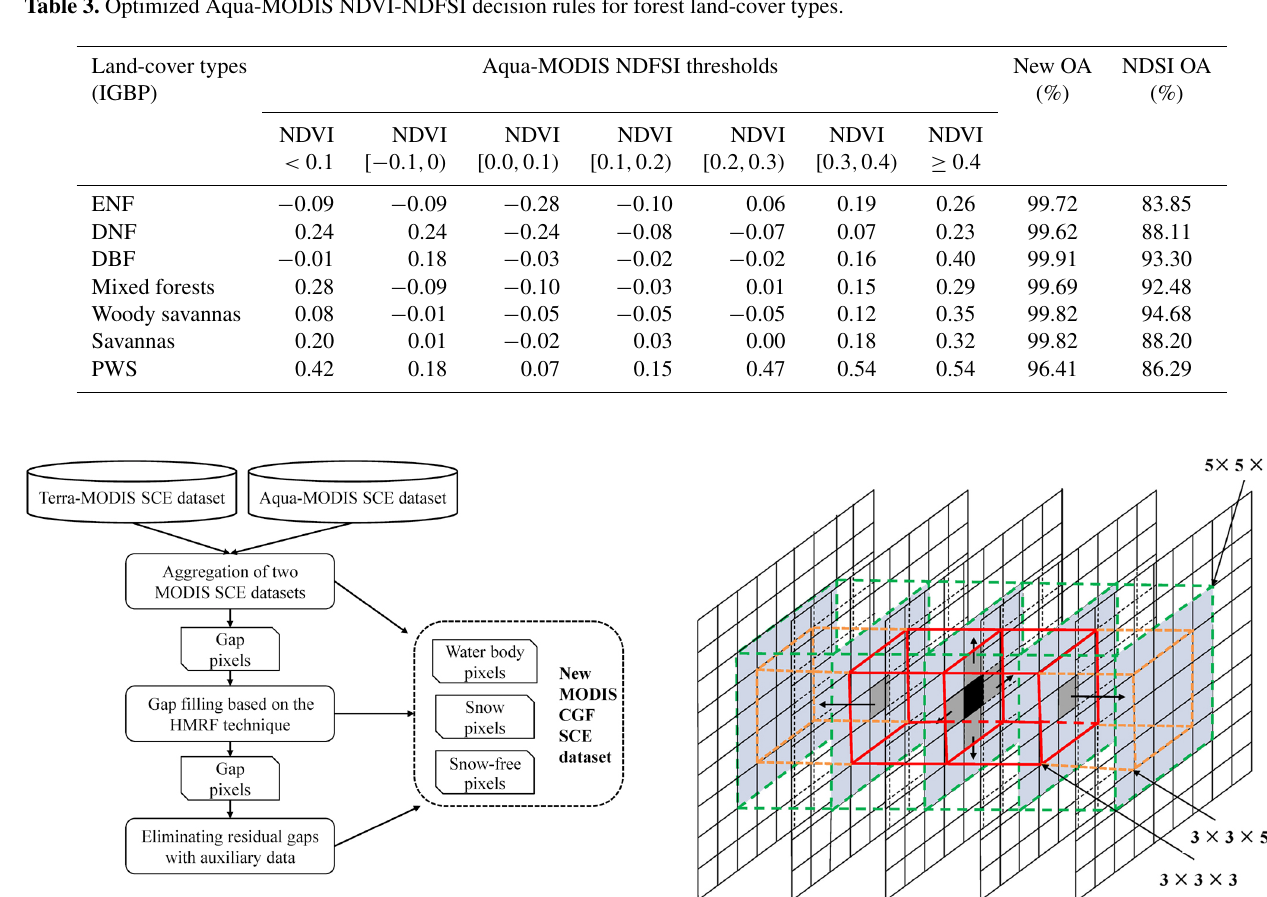
Figure 5. Flowchart of the new cloud-gap-removing algorithm.